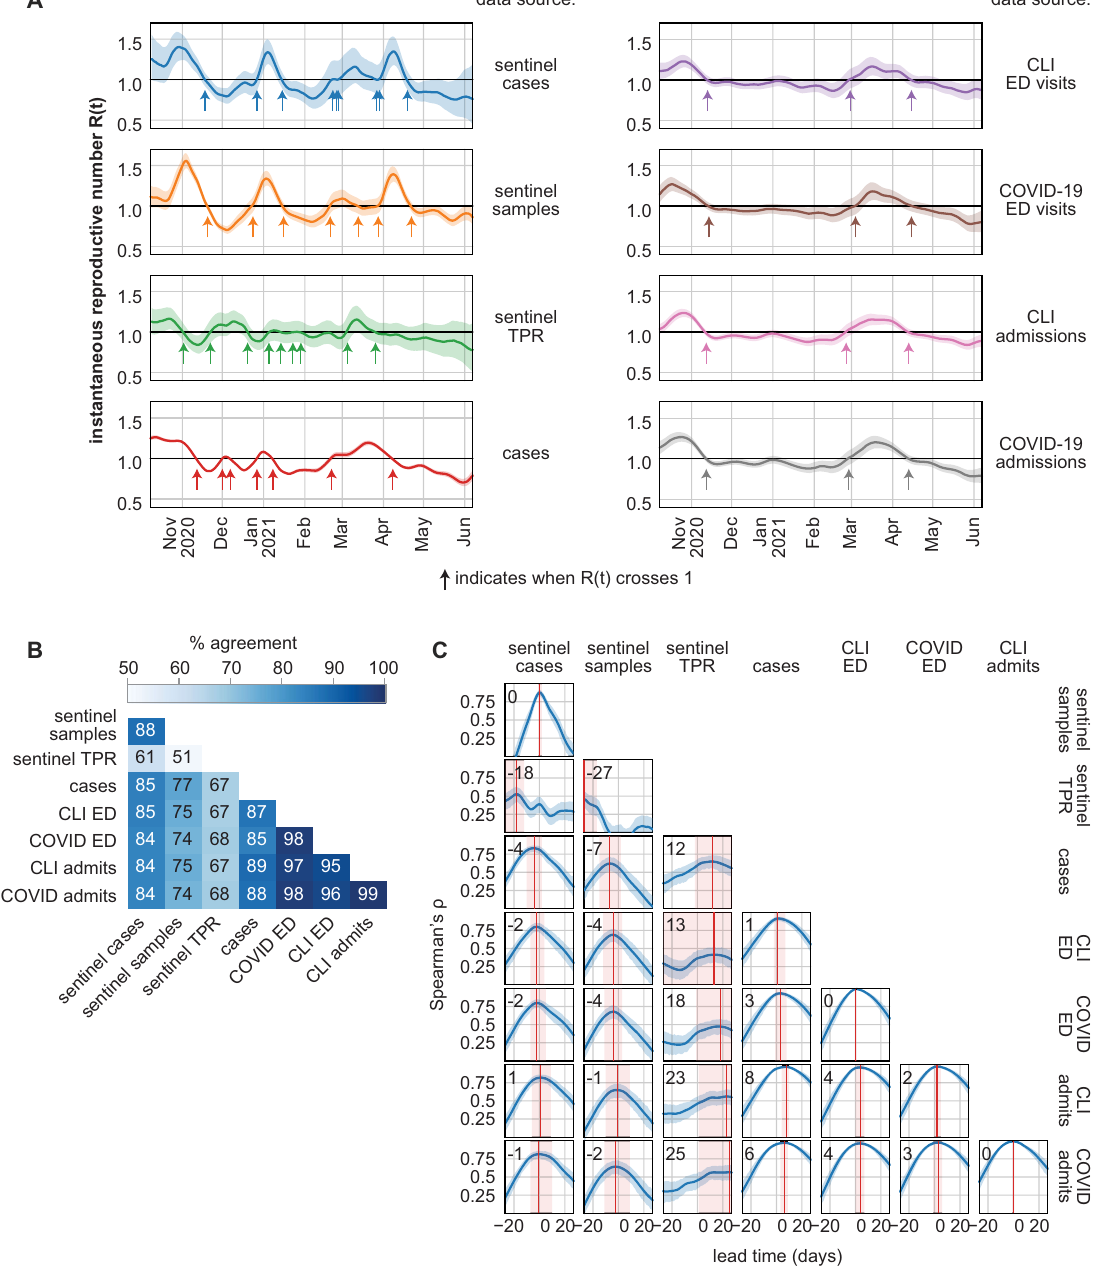
displaced relative to the series on the y-axis. Positive lead time indicates that the x series leads the y series and negative leadtime indicatesthatthe x serieslags the y series. Solid blue lines show nominal values of Spearman ’ s ρ and shaded regions indicate the 95% con fi dence interval about the nominal value from 1000 boot- strapped estimates. Red solid lines indicate the lead time at which maximum cor- relationisachieved;thisleadtimeisnotedintheupperleftcornerofeachplot.Red shaded regions indicate an uncertainty bound for the lead time (see Methods). Seven-day smoothed time series are shown in Supplementary Fig. S6. TPR